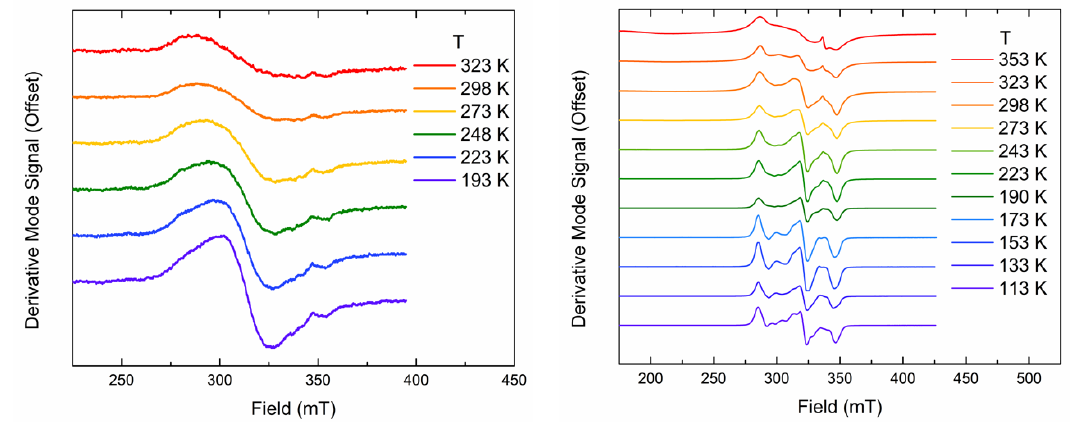
Figure 7. Variable temperature EPR spectra of complex 1 ( left ) and 2 ( right ) at variable temperature.